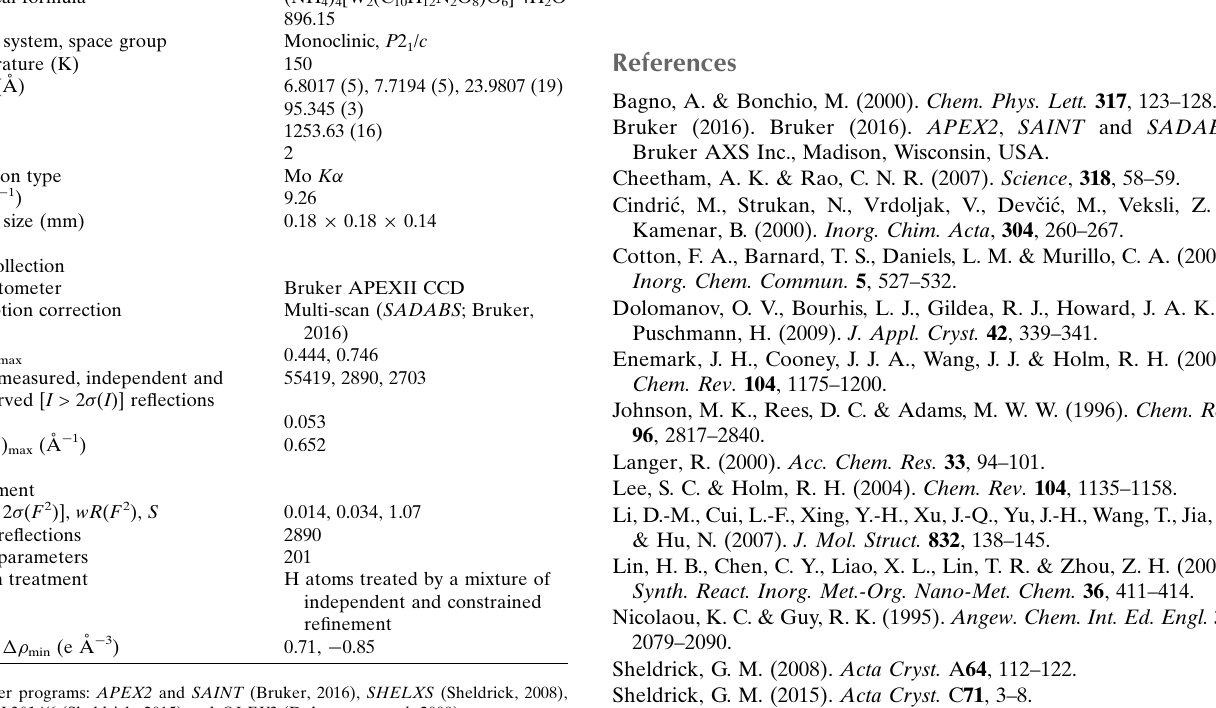
Table 2 Experimental details. Crystal data Chemical